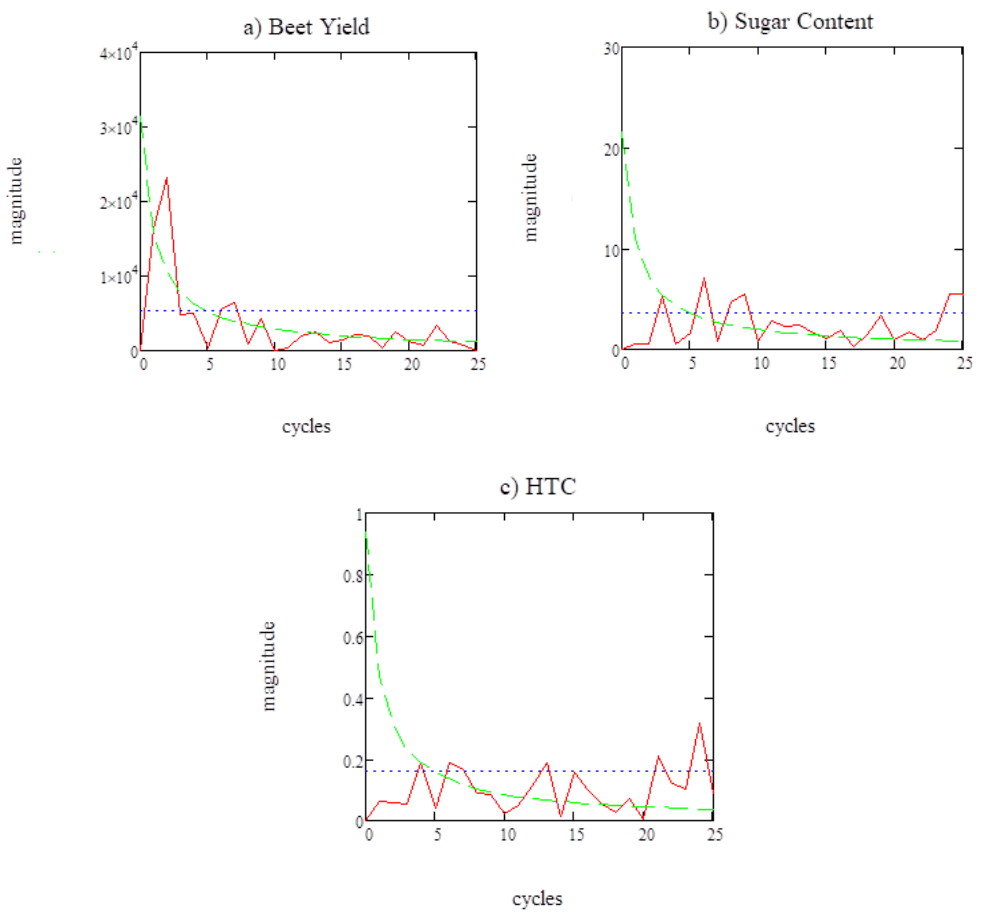
Figure 7. The time series of ( a ) sugar beet yield (tons ha − 1 ), ( b ) sugar content (%) of the beets, and ( c ) HTC (mm ◦ C − 1 ) converted to wave space using a Fourier transform. The abscissa (ordinate) is cycles 59 y − 1 (spectral power). The units of the transformed quantity (ordinate) are the square of those in the time series. The blue dotted (green dashed) lines are the 95% confidence level curves using [30] assuming a white (red) noise spectrum.